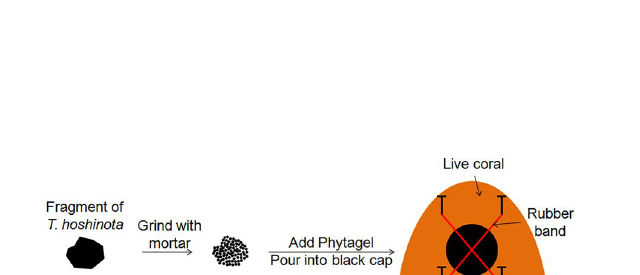
Figure 8. The design of sponge fragment experiment.